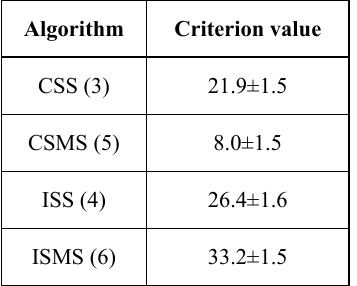
Table 1. Average distinguishability criterion values.